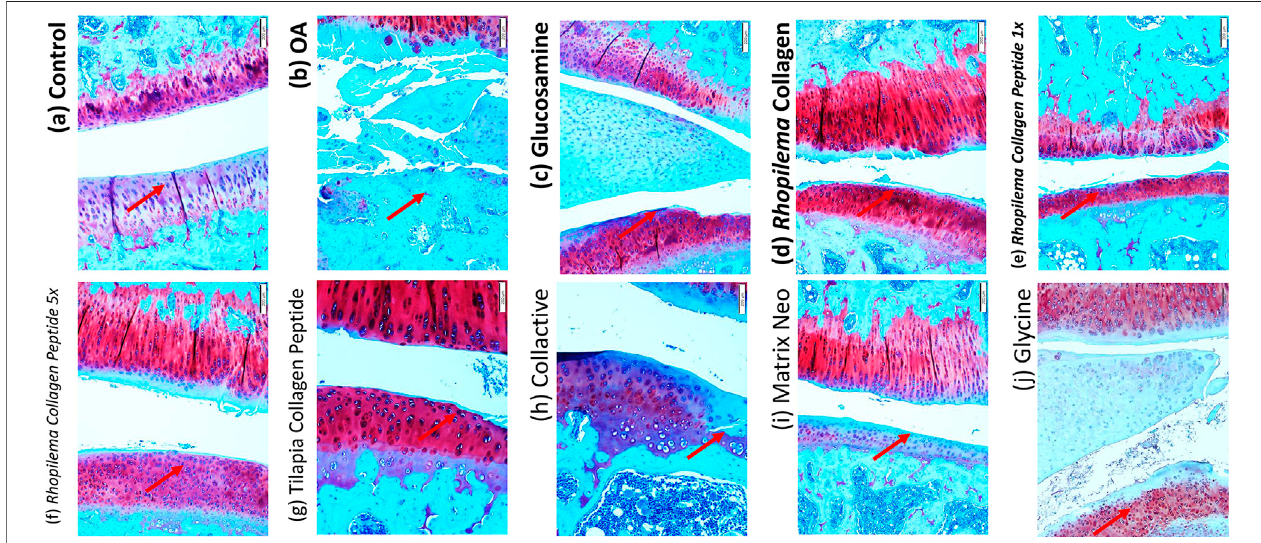
FIGURE 5 | Histological analysis by Safranin O staining difference between the knee joint in ACLT+MMx surgery-induced OA male rats after treated with different samples.